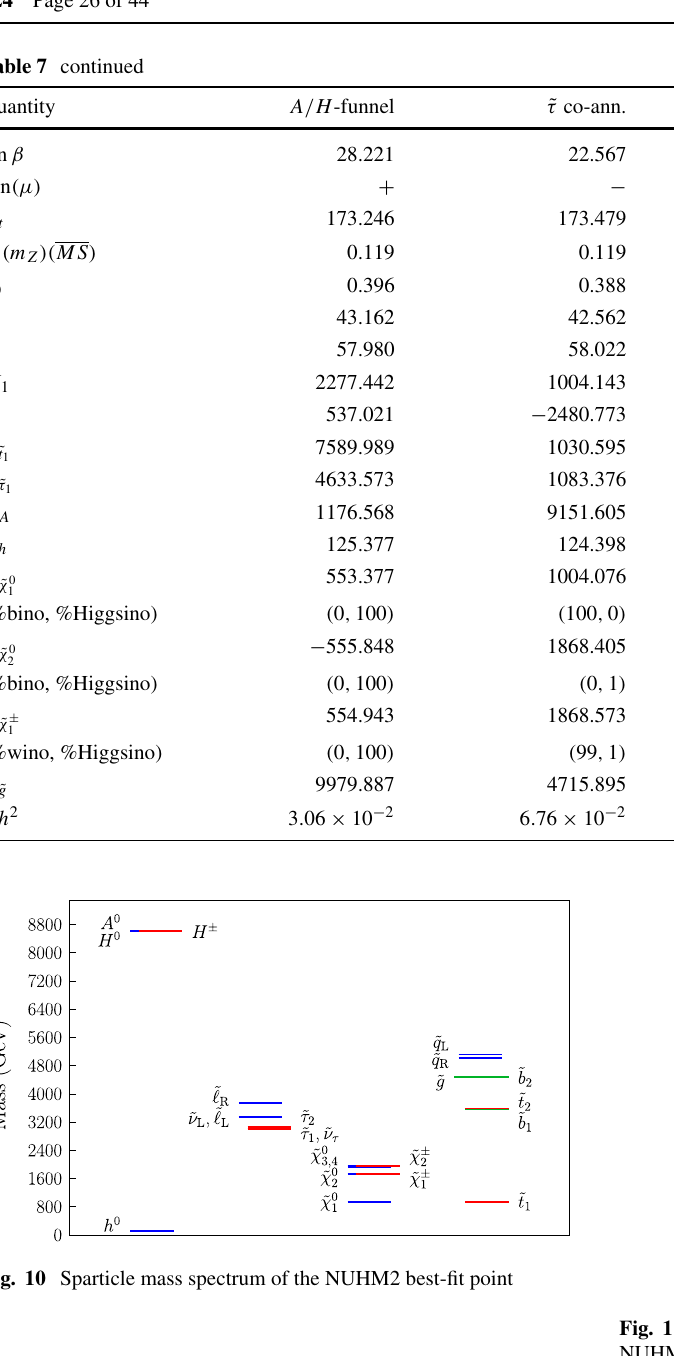
− m difference m ˜ is shown in the top panels of Fig. 13 ˜ χ 0 t 1 1 in red, while Fig. 14 shows the 2D profile likelihood in the ˜ t − ˜ χ 0 mass plane. The low-mass stop solutions all satisfy 1 1 the relic density constraint through stop co-annihilation, giv- ing stop–neutralino mass differences below ∼ 50 GeV. For very small mass differences, below the mass of the b